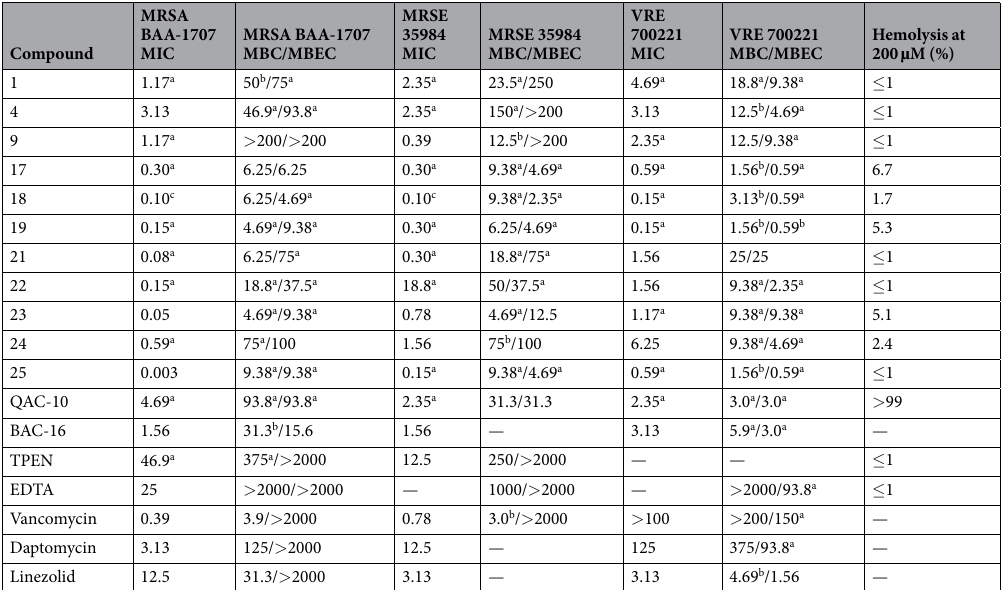
Table 3. Summary of biofilm eradication and hemolysis studies with Halogenated Phenazines. Notes: a Midpoint for a 2-fold range in observed values. b Midpoint value of a 4-fold range in values. c Lowest concentration tested. All biological results summarized in this table were generated from three independent